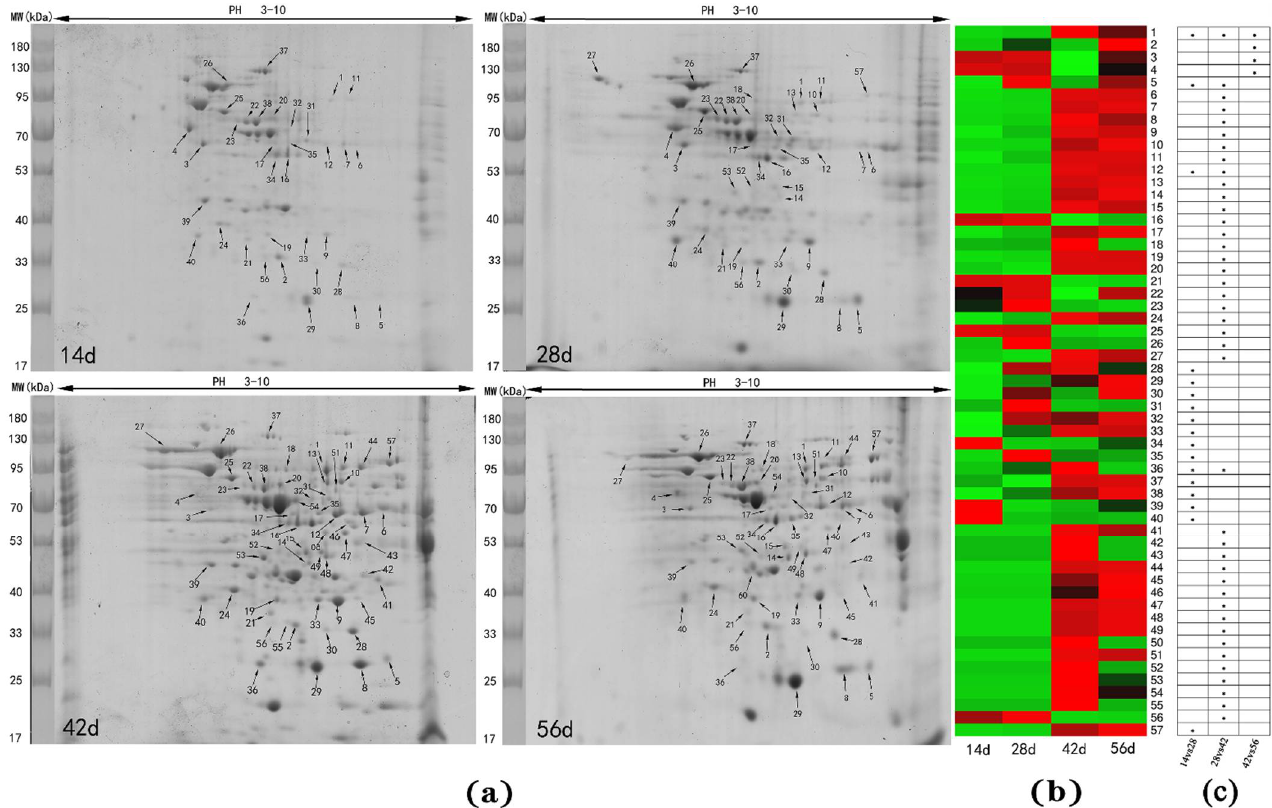
Figure 2. ( a ) Two-DE profiles of liver in Muscovy duck, day (d); ( b ) The relative expression of differentially abundant proteins at different stages, the gradient from green to red represents a gradual increase in protein expression; ( c ) The p -values of spots at 14 vs. 28, 28 vs. 42 and 42 vs. 56, p < 0.05 = *.